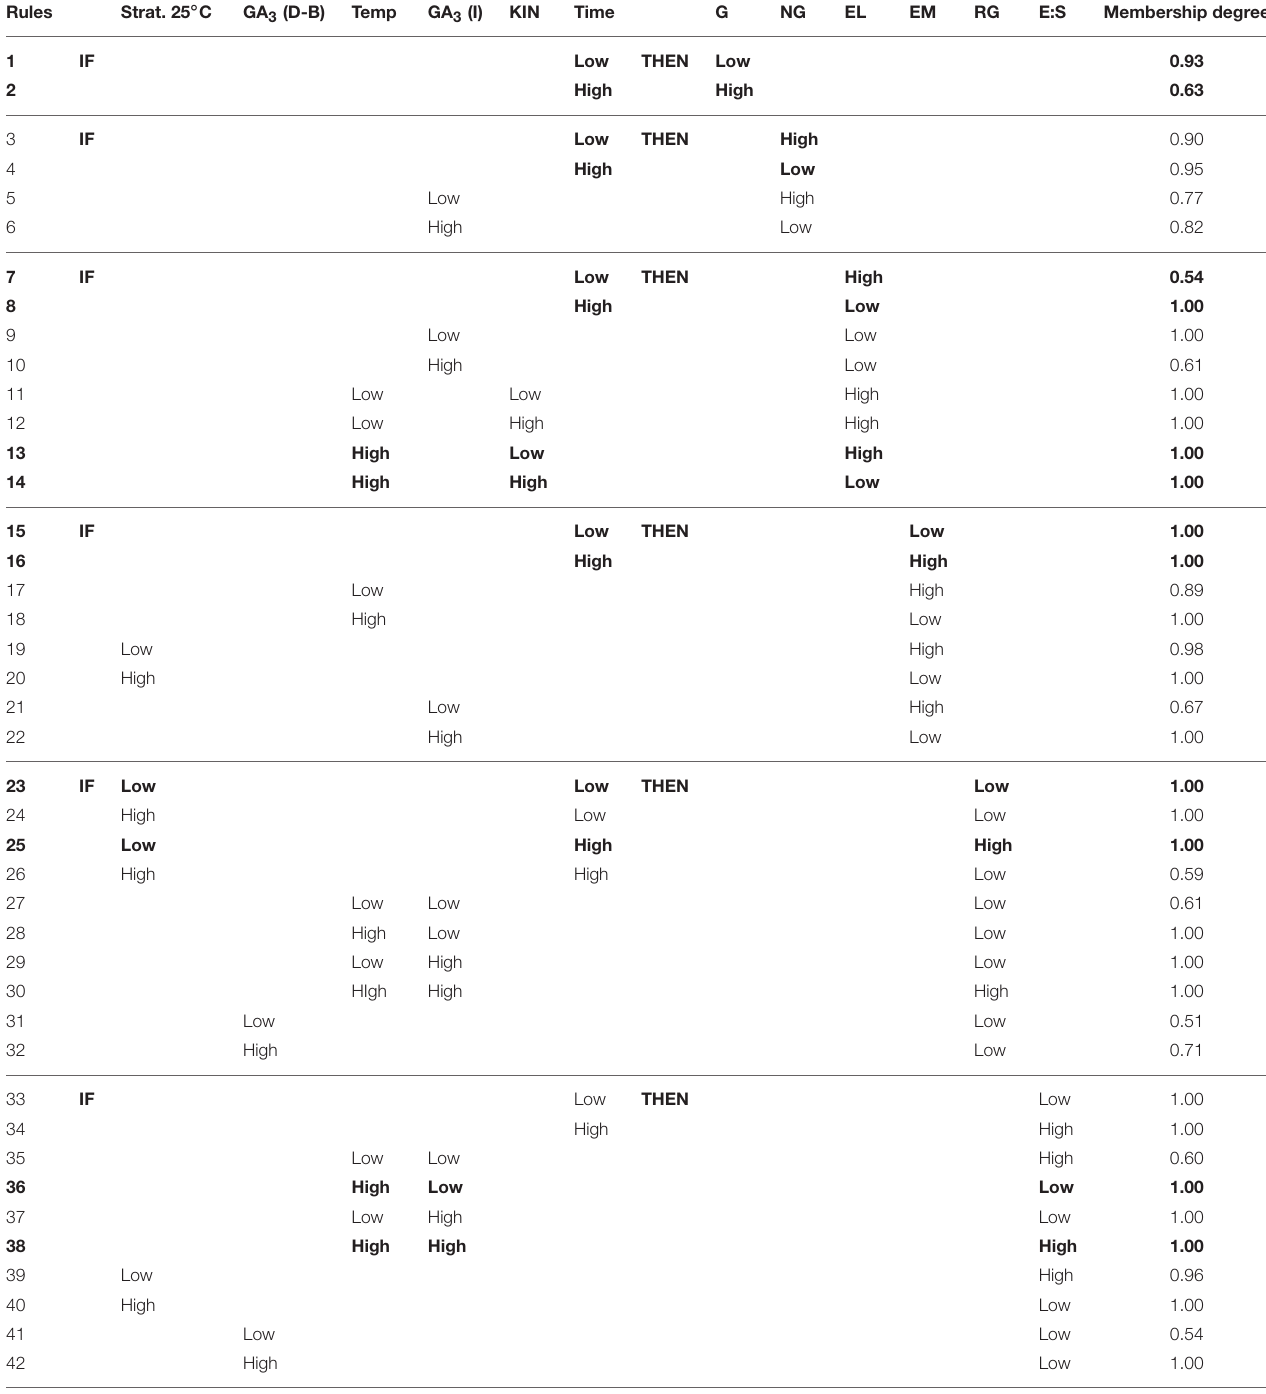
TABLE 5 | Rules generated by neurofuzzy logic.